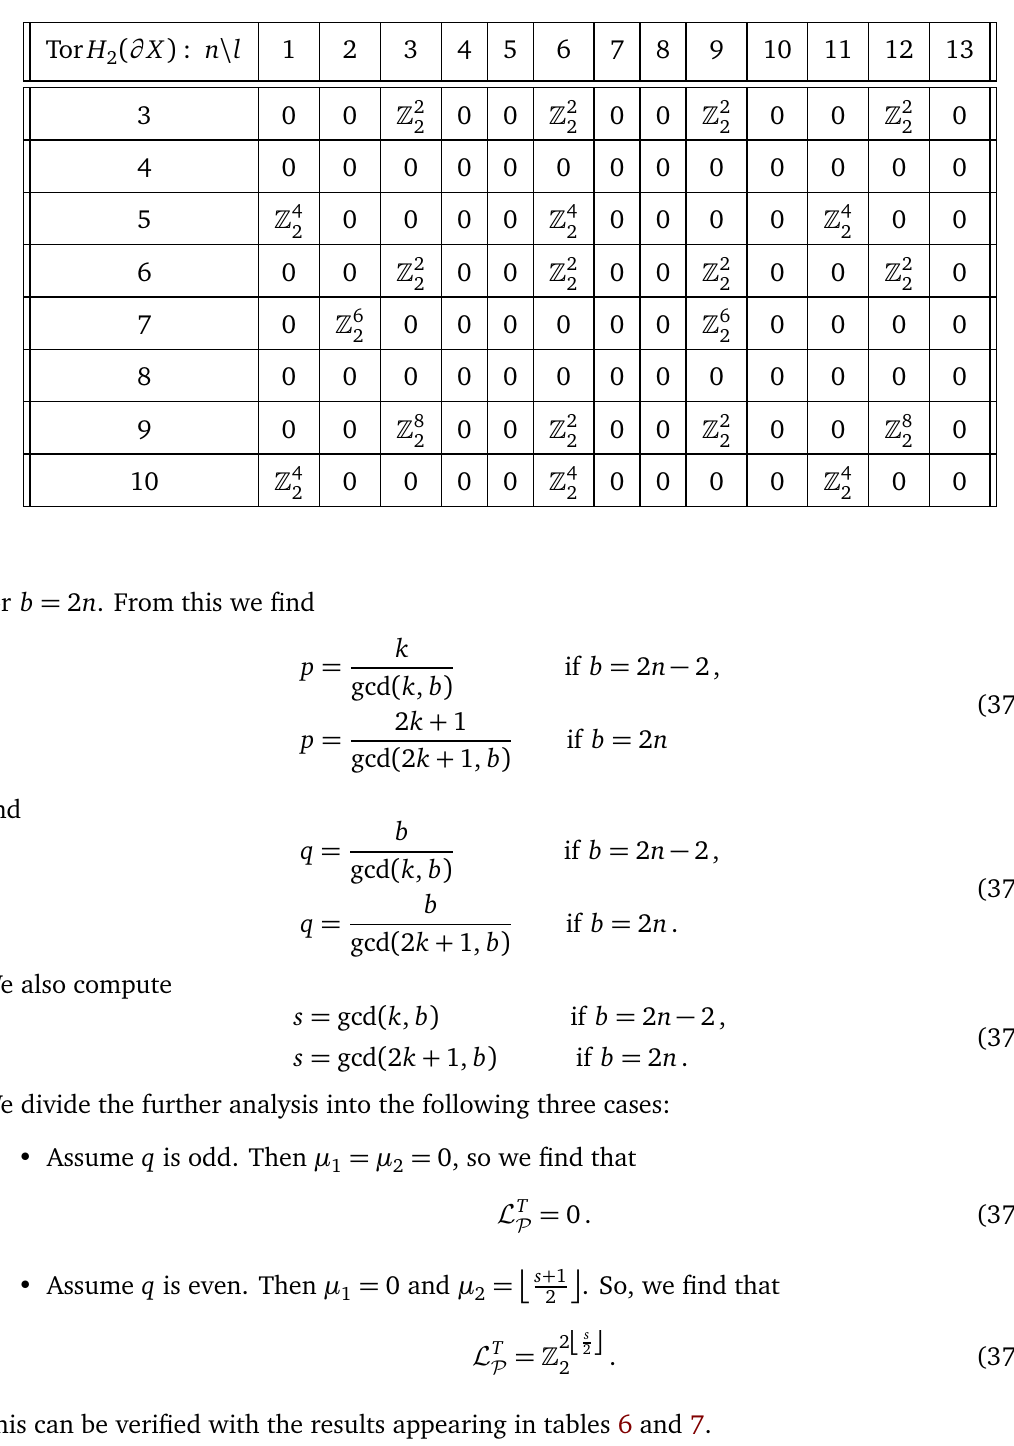
Table 7: Defect groups for the x 2 right, n increases top to